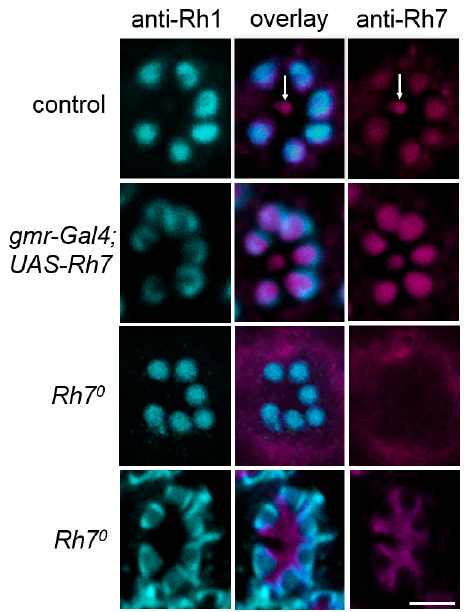
Figure 5. Single confocal stacks (2 µ m thick) of whole-mount retinas labeled with anti-Rh1 (cyan) and anti-Rh7 (magenta). Labeling is shown for control flies, flies with Rh7 overexpressed in all photoreceptor cells ( gmr-Gal4;UAS-Rh7 ), and the Rh7 0 mutant flies. While the anti-Rh1 antibody stained the rhabdomeres of the six outer receptor cells, the anti-Rh7 weakly stained those receptor cells, particularly in that of the inner receptor cell R8 in the control flies (arrows). In gmr-Gal4;UAS-Rh7 flies, Rh7 staining was increased in all rhabdomeres. Rh7 0 mutants showed no staining in the rhabdomeres. Either a low background staining was found (upper Rh7 0 row) or the inter-rhabdomeric space was stained (lower Rh7 0 row), as found previously [18]. Please note that Rh1-labeling was sometimes only present at the margin of the outer photoreceptor cells (here seen in gmr-Gal4;UAS-Rh7 flies and in the lower row of Rh7 0 mutants). Scale bar: 5µm.